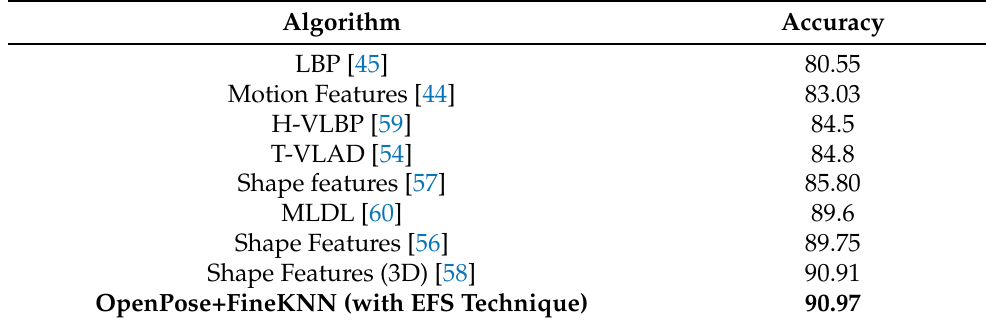
Table 9. Multi-view HAR on IXMAS dataset.